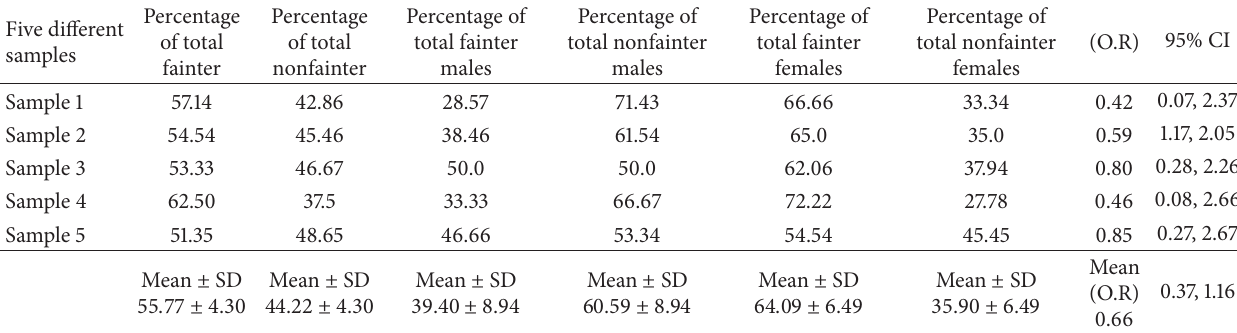
Table 3: Showing the gender wise differences in the percentage of fainting and nonfainting sufferers for BII phobia in different samples of the population. Five different samples Sample